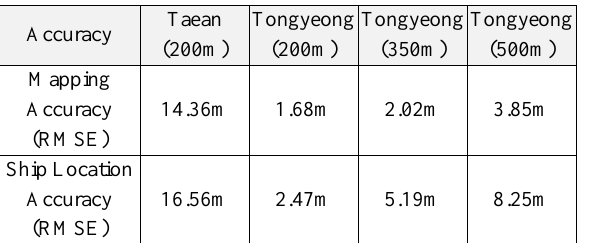
Table 13. Overall